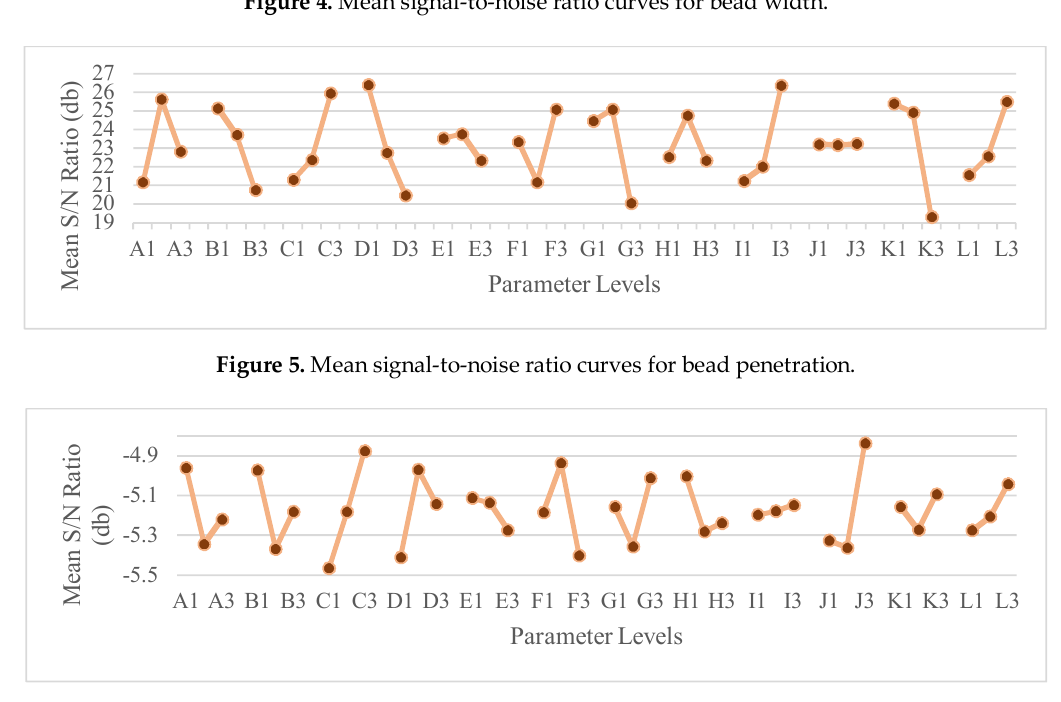
Figure 6. Mean signal-to-noise ratio curves for bead